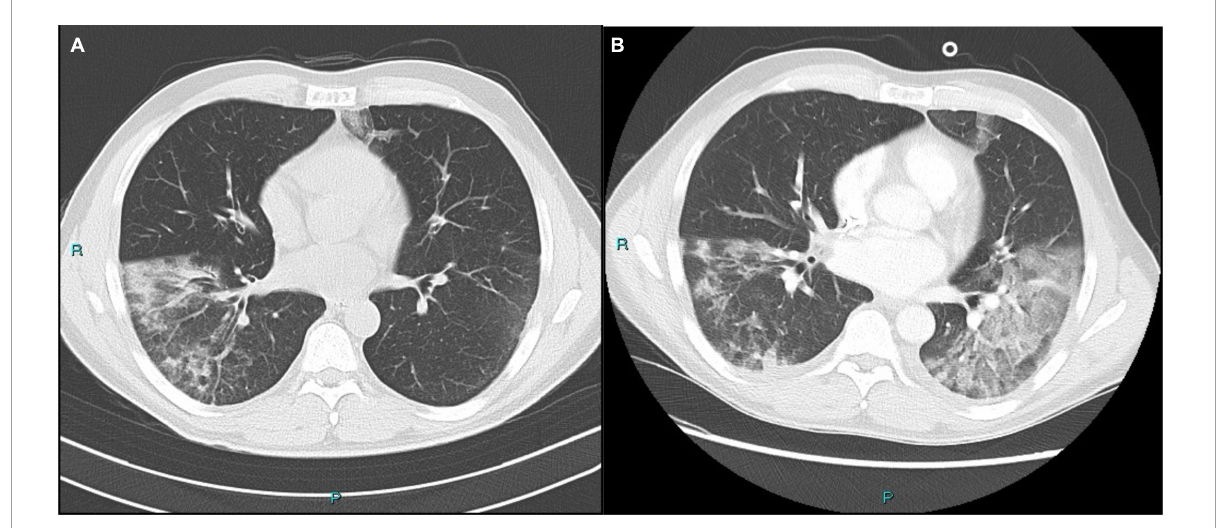
FIGURE1 (A) Bilateral ground-glass opacities with crazy-paving aspects and more consolidated components, greater at right lower lobe. (B) Extension of pulmonary opacities at the left basal lobe compared to the previous